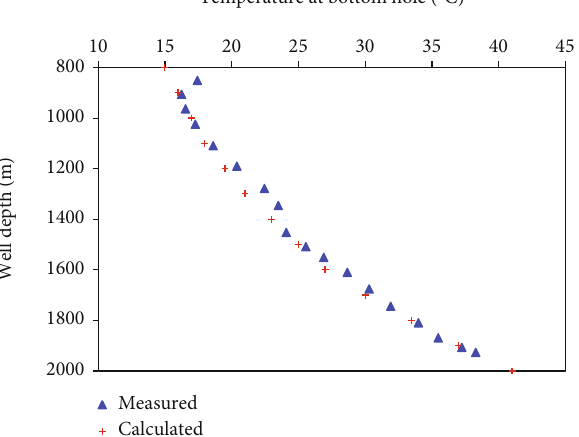
Figure 3: The calculated and measured temperature values in the wellbore.